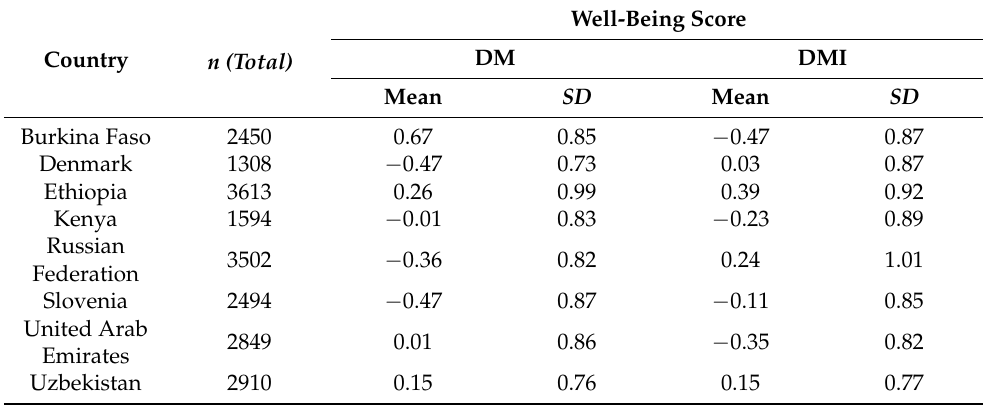
Table 1. Well-being scores by